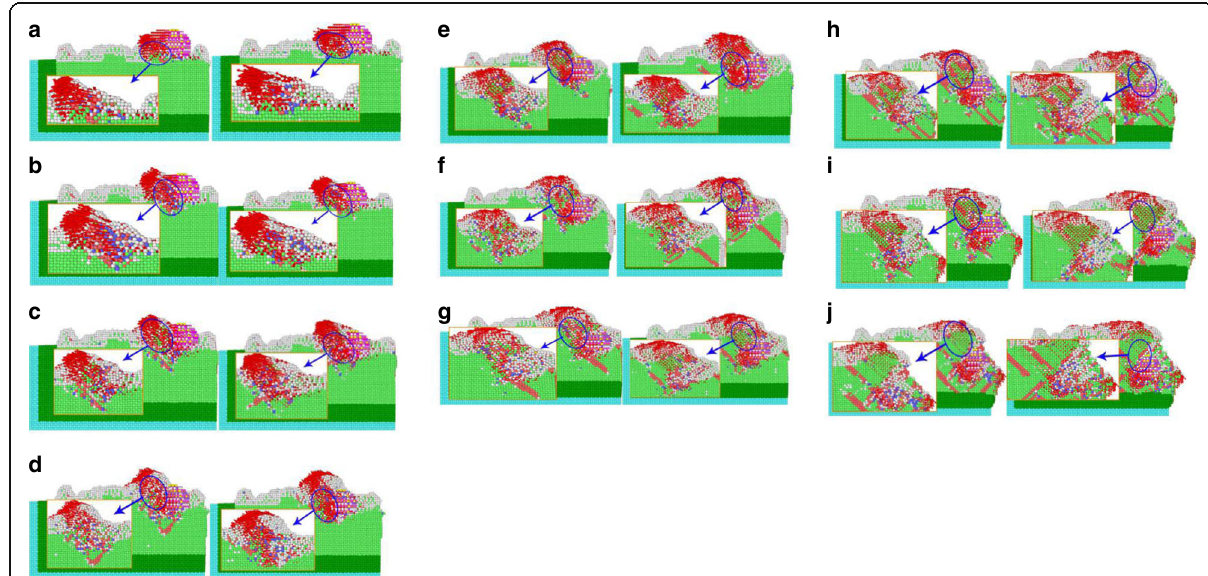
Fig. 10 Different cutting angles cause to atomic displacements. Figure 10 describes atomic displacements of different cutting angles. When the single crystal SiC abrasive particles collide with the workpiece cutting copper in different directions, with SiC abrasive grains being cut, cutting depth increases, since the speed of the cutting direction is at 80 m/s, the [001] direction The moving speed is v z = 0.8 ∗ sin θ , with increasing cutting depth of the cutting angle, [001] in the same cutting angle increases simulation steps, the depth of cut is large at the same time. a 0° displacement. b 5° displacements. c 10° displacement. d 15° displacement. e 20° displacement. f 25° displacement. g 30° displacement. h